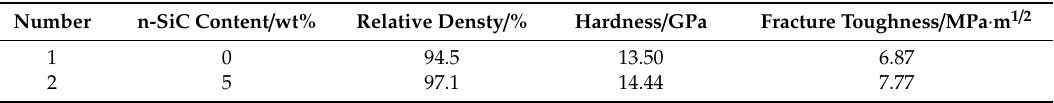
Table 2. Comparison of properties of Si 3 N 4 with SiC nanopowders content of 0% and 5% at 1600 °C for 10 min (wt%).